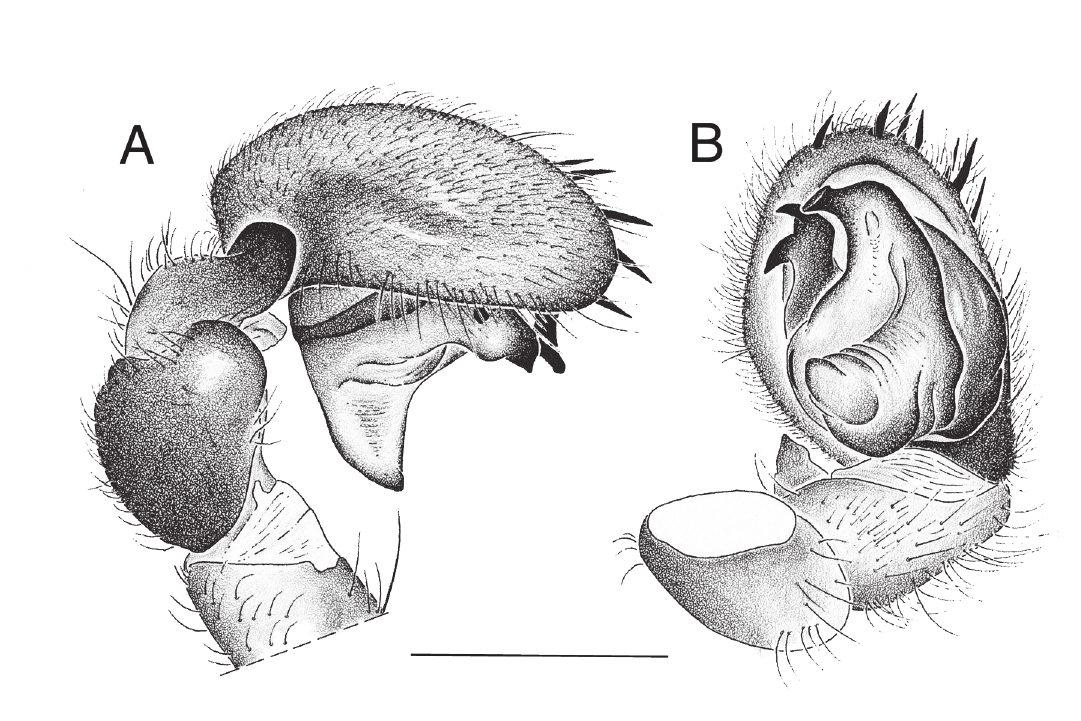
Fig. 7. Palindroma aleykyela gen. et sp. nov., ♂ (MRAC 153248). A . Palp, retrolateral view. B . Idem, ventral view. Scale bar =